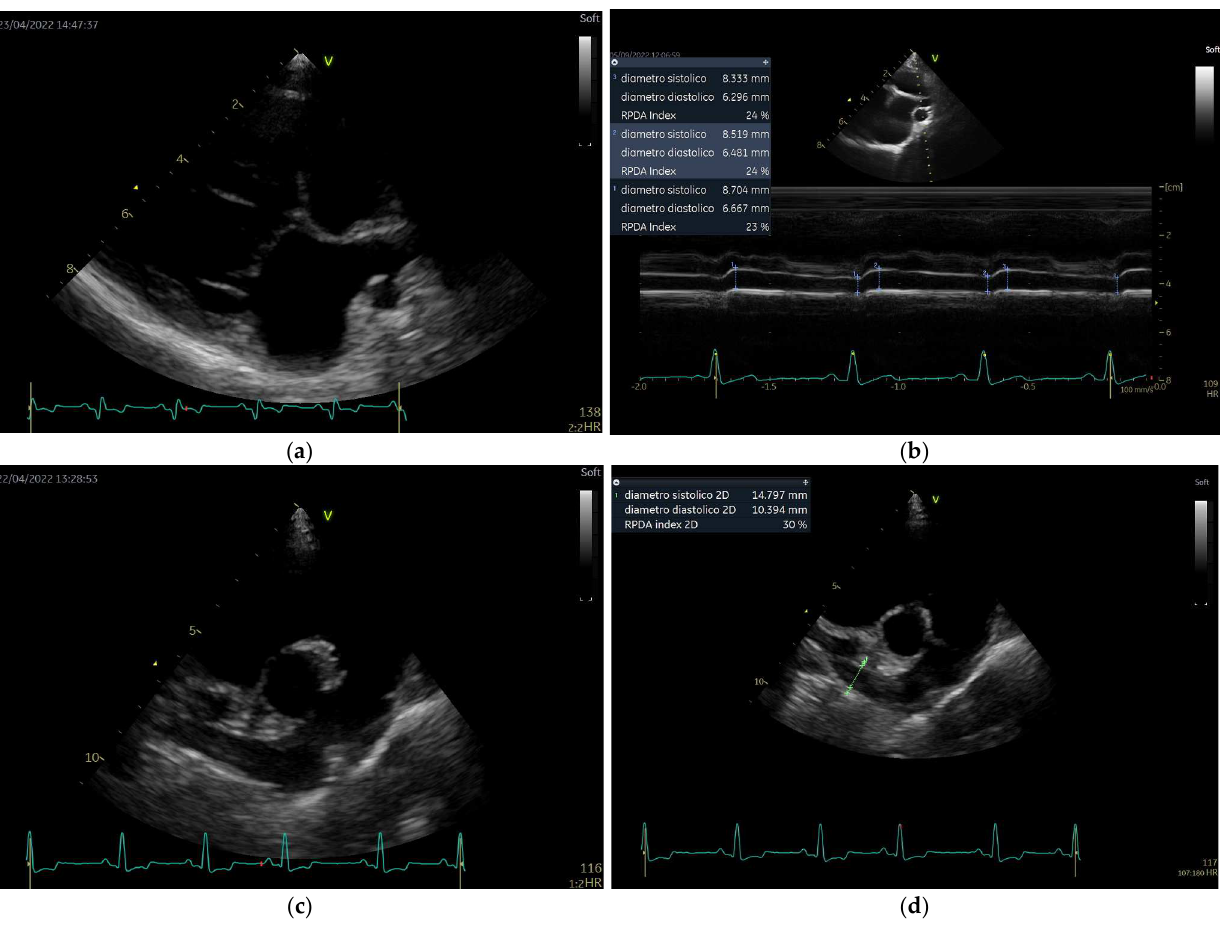
Figure 2. Echocardiographic views and measurement method. ( a ): View 1 (see full text); ( b ): diameter measurement of right pulmonary artery in M-mode from View 1; ( c ): View 2; ( d ): diameter measurement of right pulmonary artery in B-mode from View 2.